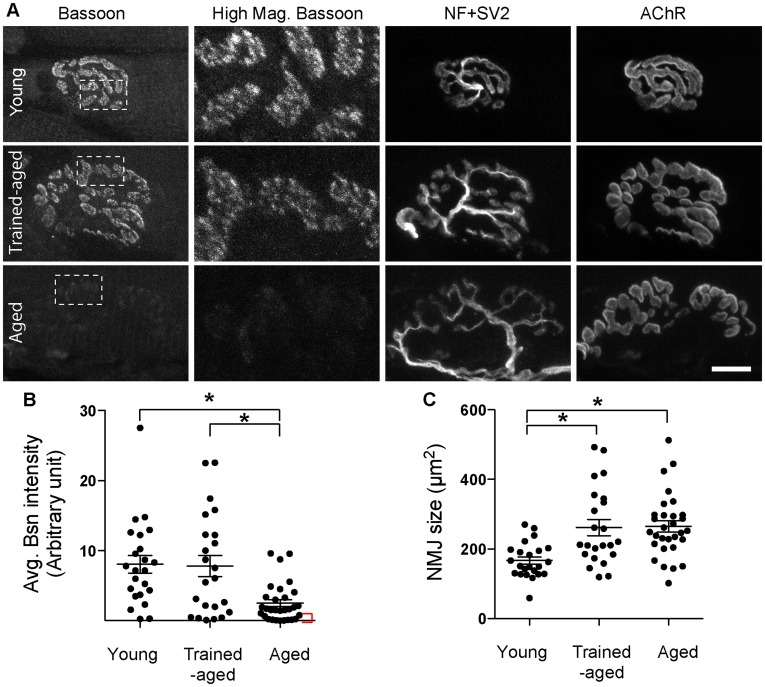
Exercise ameliorated the active zone protein Bassoon level in aged NMJs.(A) NMJs of trained aged rats (trained-aged) showed higher Bassoon signal intensity compared to the NMJs of un-trained aged rats (aged). Two-year-old rats underwent isometric strength training of tongue muscles for two months. Genioglossus muscles of the tongue were sectioned and stained with antibody against Bassoon (active zone marker), neurofilament and SV2 (nerve morphology, NF+SV2), and α-bungarotoxin (acetylcholine receptors, AChR). Highly magnified Bassoon staining of the area indicated by white dotted boxes are shown in the second column from the left (High Mag. Bassoon). NMJs of young rats (young, postnatal day 56) exhibited higher Bassoon signal intensity than aged rats, similar to our previous mouse study [15]. Scale bar: 10 µm. (B) Average signal intensity of Bassoon was significantly higher in NMJs of young rats and trained-aged rats compared to those of untrained-aged rats (mean ± standard error in arbitrary intensity units: young rats, 8.06±1.27; trained-aged rats, 7.81±1.51; and aged rats, 2.51±0.51; four rats in each group). The red bracket indicates a subgroup of NMJs in aged rats with a minuscule level of Bassoon signal. Young rats and trained-aged rats were not significantly different. (C) The NMJ size did not change significantly by the isometric strength training (trained-aged rats, 261.7±23.2 µm2; untrained aged rats, 264.8±16.5 µm2). Young rats had smaller NMJs (166.5±10.5 µm2) than the aged rats (trained and un-trained), which is consistent with the body and tissue size difference between these two ages. Quantifications in (B, C) are from four rats in each group (a total of 23 – 30 NMJs) and shown by scattered plot with the mean ± standard error by lines. Asterisks indicate significant differences by one-way ANOVA and Bonferroni’s multiple comparison post-test, P<0.05.